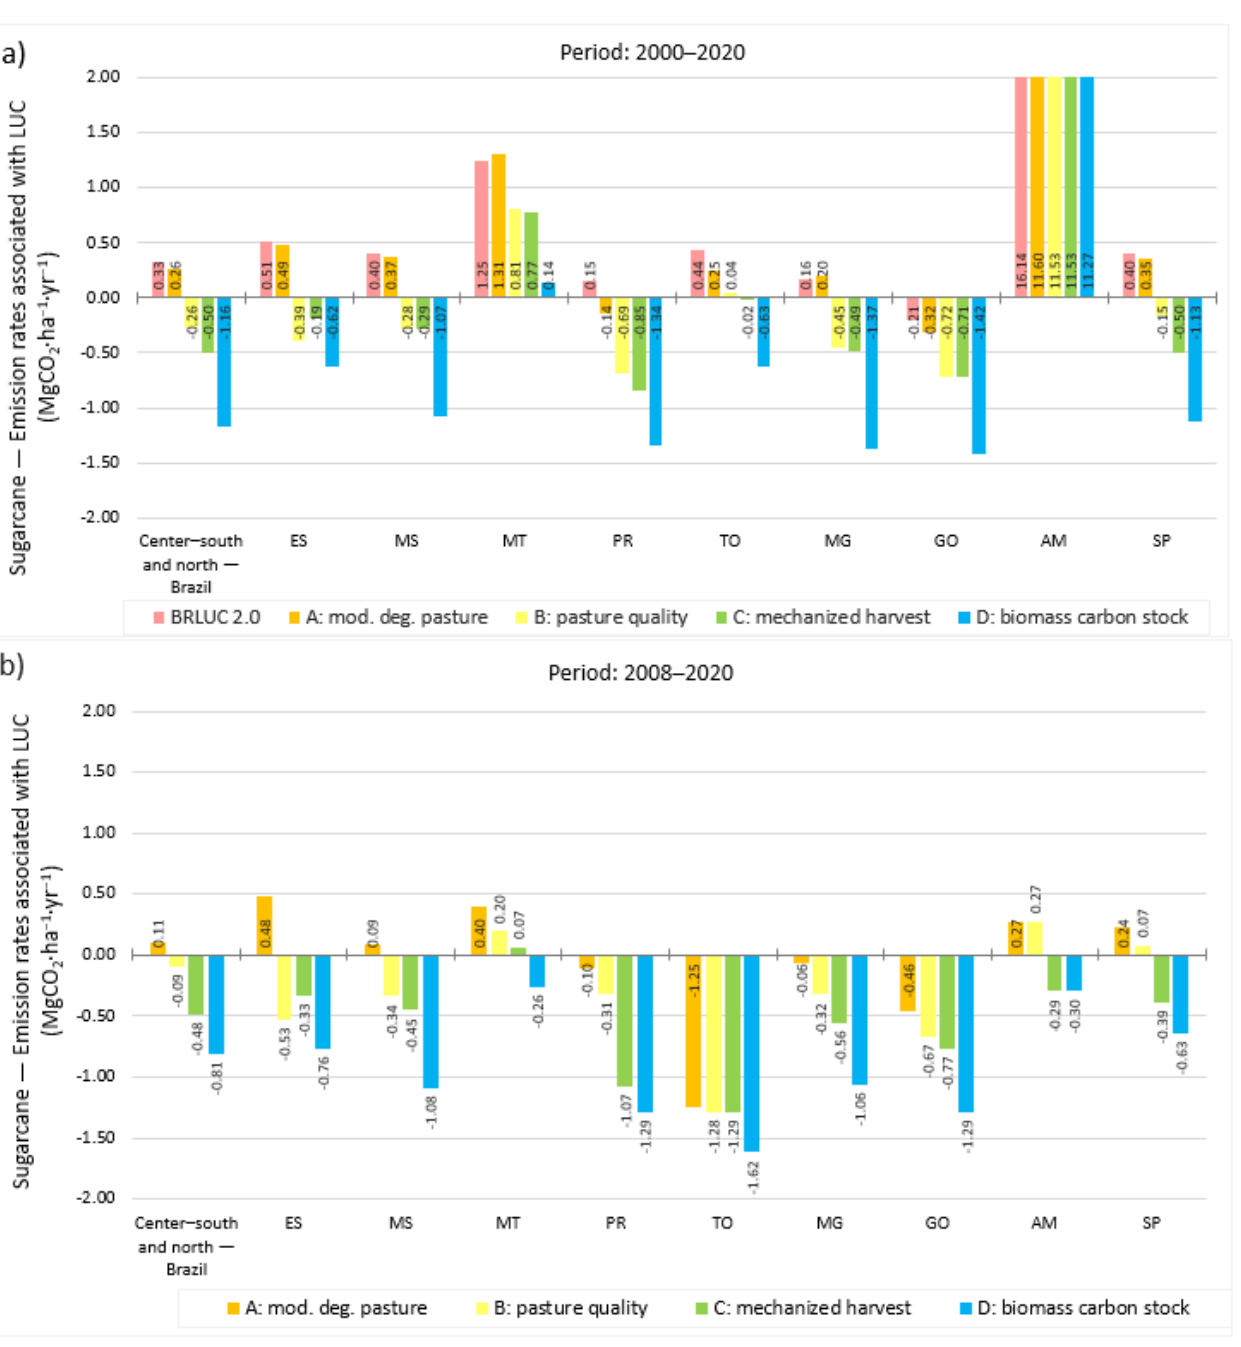
Figure 7. Annual CO 2 emission rates associated with LUC due to sugarcane, estimated in each parametrization in the center–south and north regions of Brazil and in the analyzed states, in the periods ( a ) 2000–2020 and ( b ) 2008–2020. The BRLUC 2.0 LUC emission rate data correspond to the default value for sugarcane all over Brazil, not just in the center–south, according to Garofalo et al. [10]. It is shown only for the period 2000–2020, as BRLUC data for 2008–2020 are not available. Between parametrizations A and D, in relative terms, the variation in the amplitude of the annual emission rate of LUC from sugarcane in Brazil’s center–south/north was 2008–2020 (Figure 7 and Table 2). For the full period (2000–2020), the refinement in biomass stock and pasture quality had the greatest influence on the results. The exclusive effect